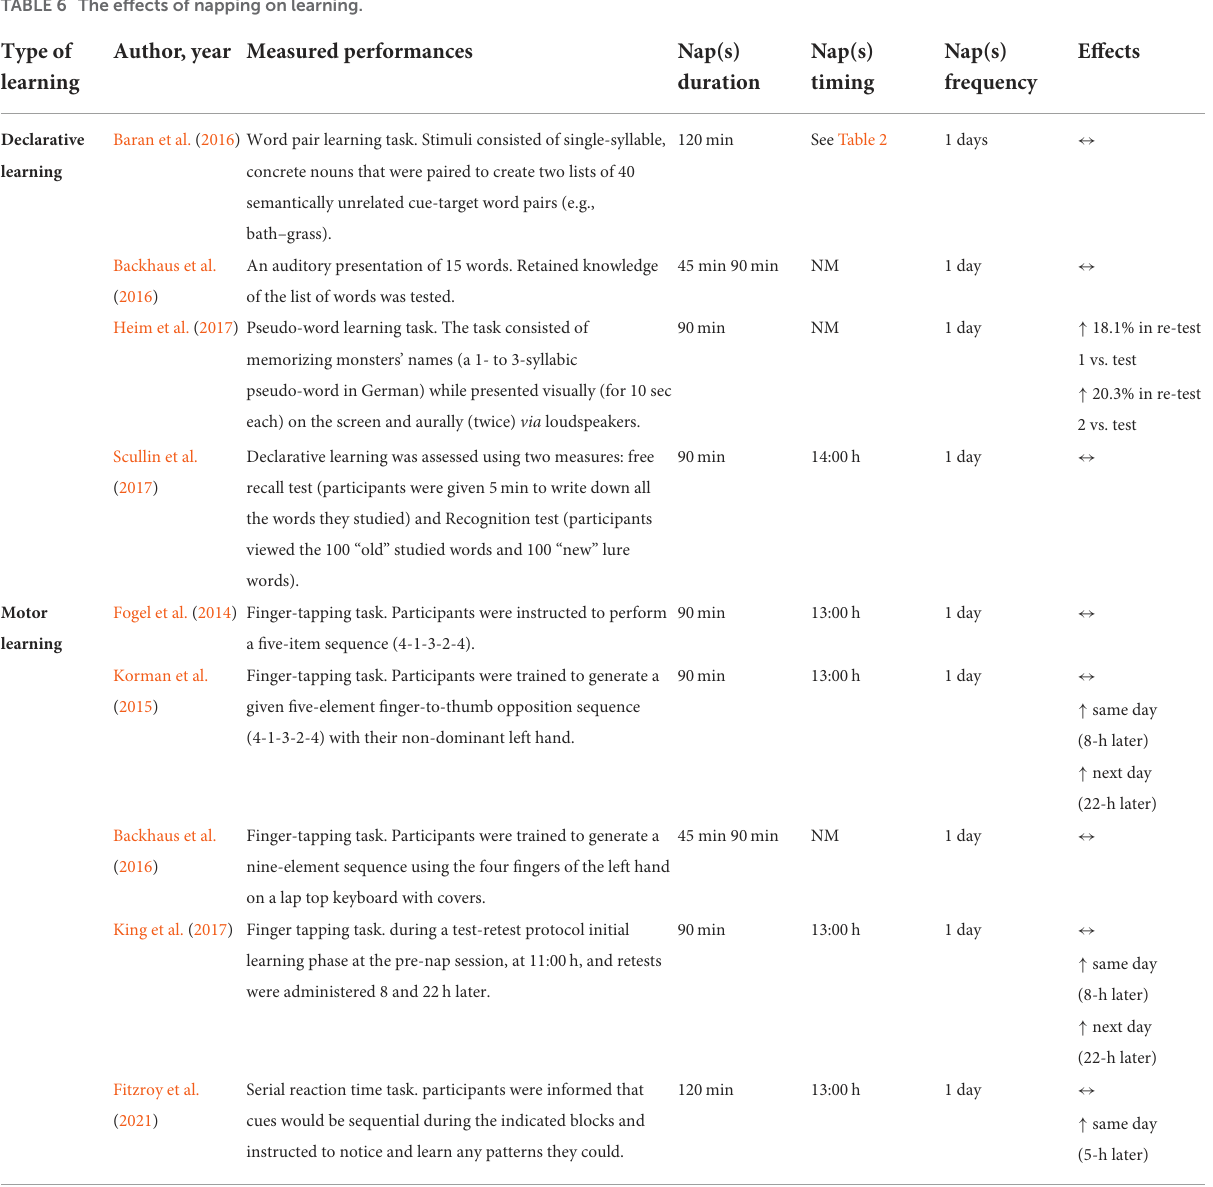
TABLE 6 The effects of napping on learning. Type of learning Declarative